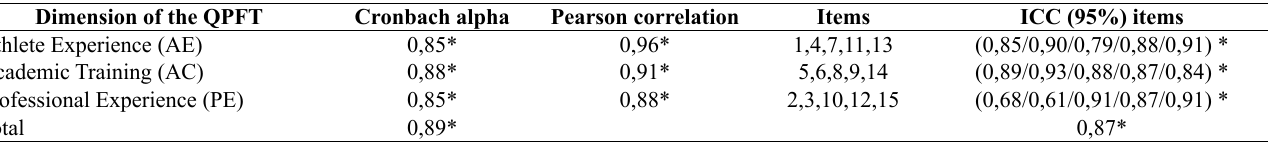
Table 1. Internal consistency of the dimensions of the Brazilian version of the QPFT and reliability of dimensions and items in the test-retest. Dimension of the QPFT Cronbach alpha Pearson correlation Items